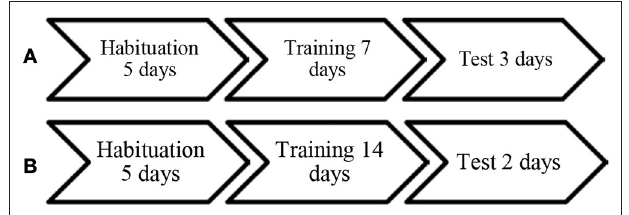
FIGURE 2 | Timeline of training and testing of the two batches, (A) batch 1 and (B) batch